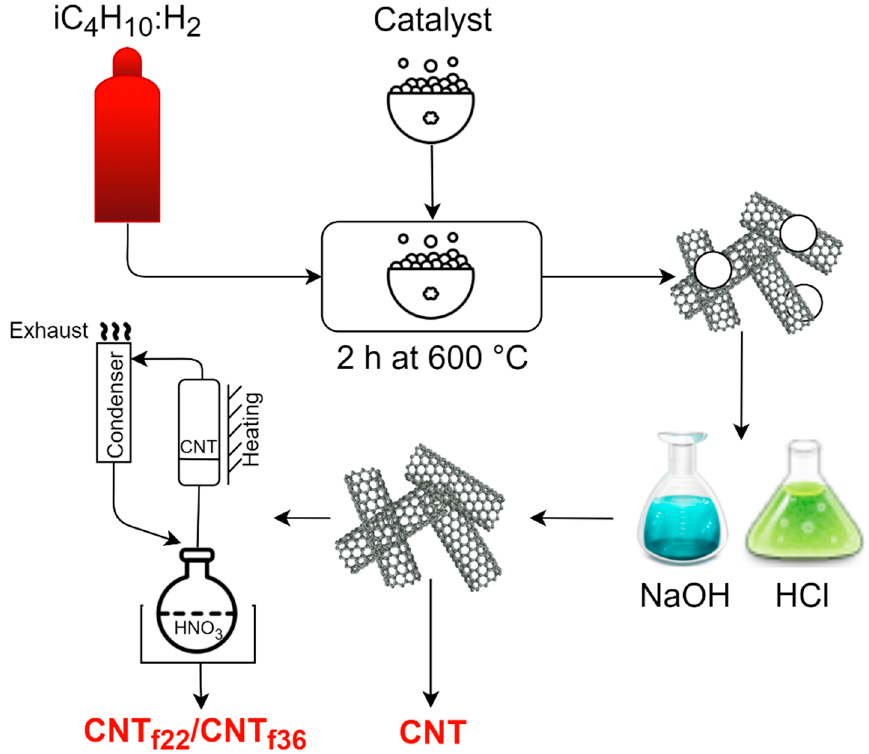
Figure 1. Filler synthesis procedure.